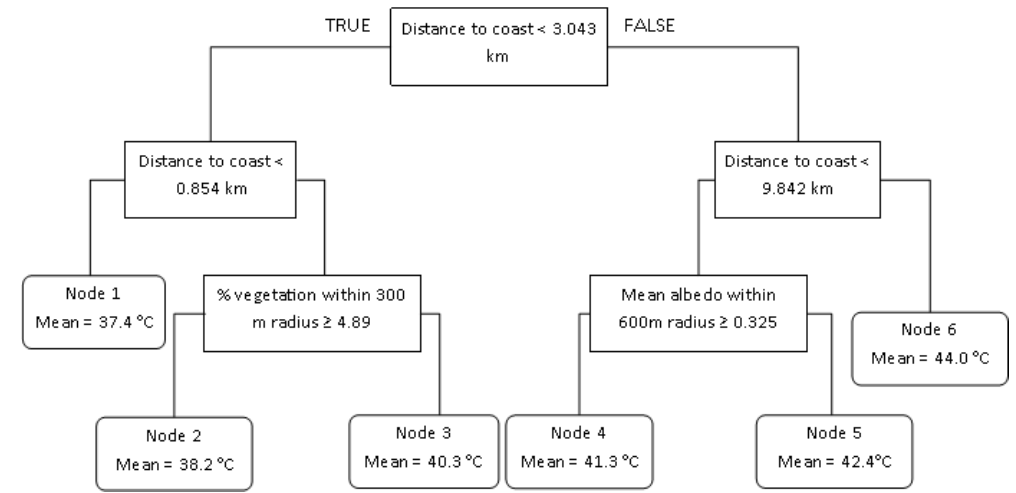
Figure 4. Example of Regression Tree Analysis with terminal nodes for 12 May 1 pm.